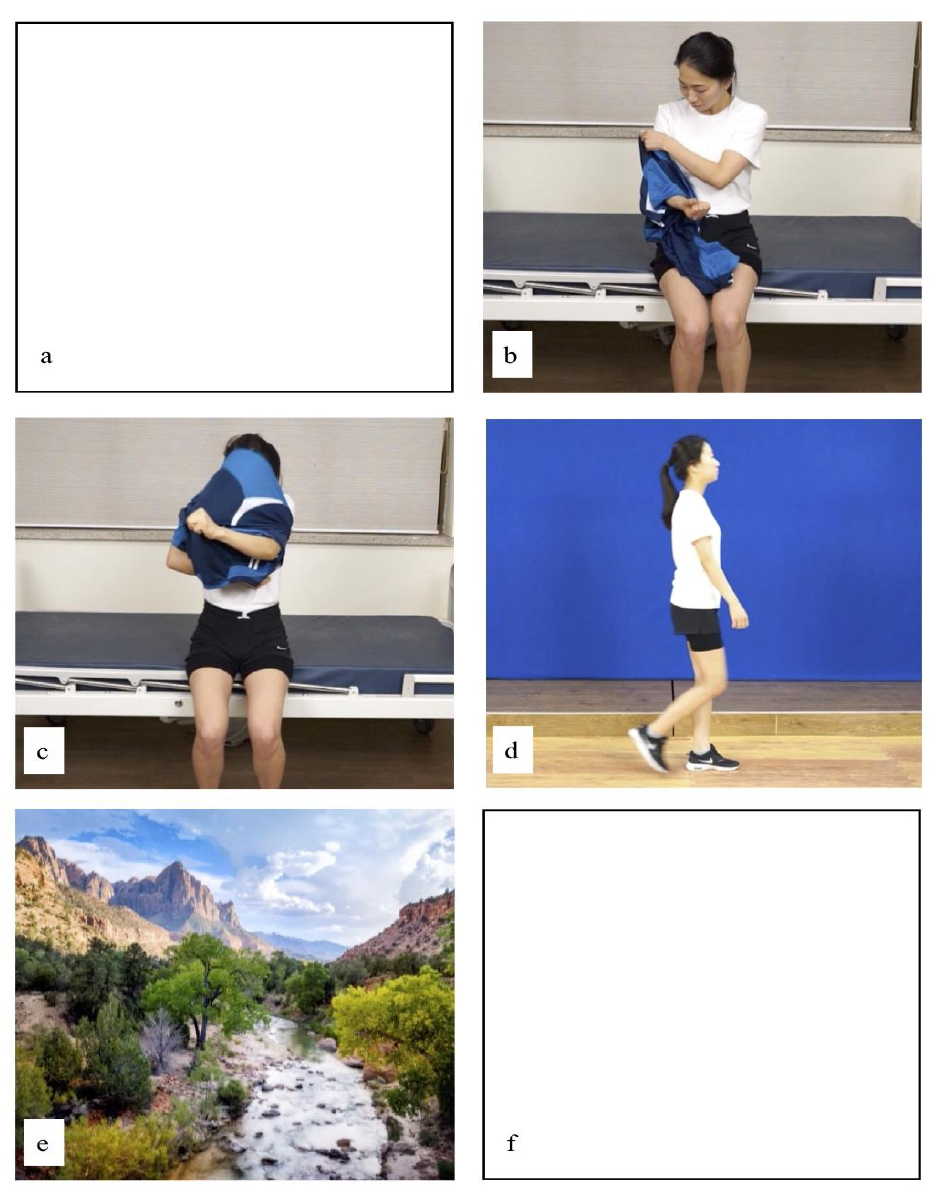
Figure 2. Action and landscape imagery conditions. (( a ). baseline, ( b ). dressing, ( c ). undressing, ( d ). gait, ( e ). landscape imagery, and ( f ). post-baseline).